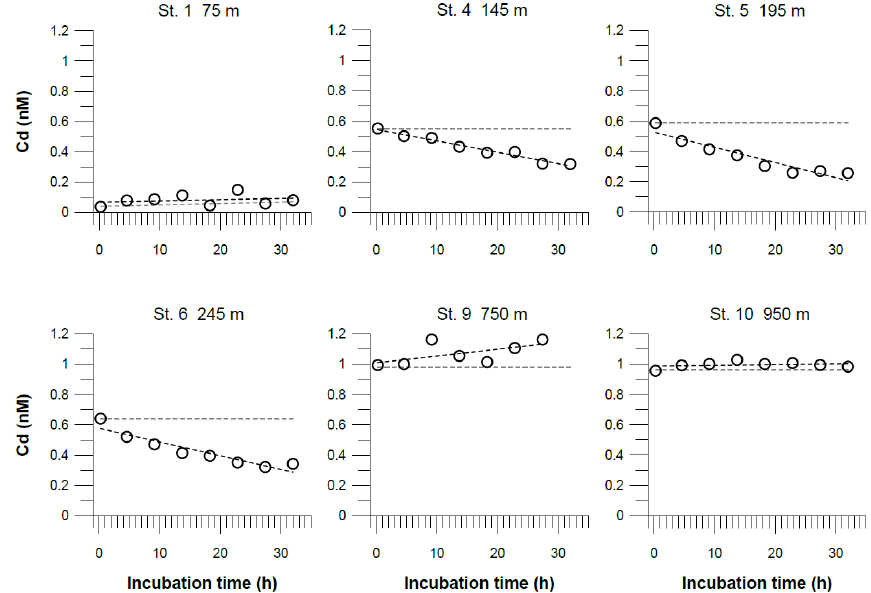
Figure 7. Dissolved Cd concentrations in incubated bottom waters from benthic chamber incubations. The black dashed line represents the linear regressions of the concentration change over the incubation time. The equations for these linear regressions are listed along with the coefficients of determination ( R 2 ) in Table S4. The gray dashed line represents the theoretical concentration gradients over the incubation time based on our benthic diffusive fluxes (Table 3). The analytical error is smaller than the symbol size. Table 4. Modeled half-lives ( t 1 / 2 ) of dissolved Fe within the first 4m from the seafloor at stations 3 and 4, and data used for determination of t 1 / 2 using Eqs. (4) and (5).